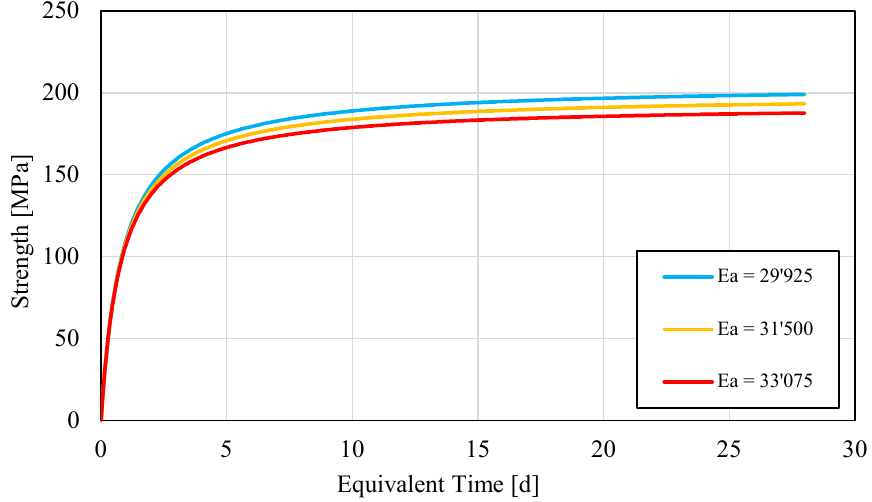
Figure 5. Sensitivity analysis of UHPC series: Strength–Equivalent Time test values for different E a